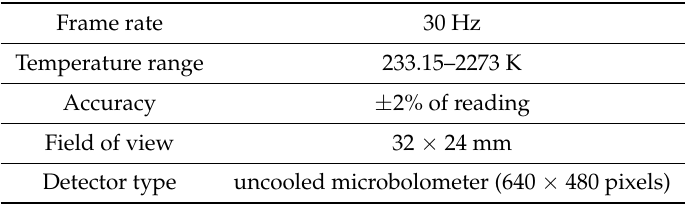
Figure 2. Thermal-electric measurement setup for investigation of inter-laminar short circuit fault. Table 1. FLIR T640 thermal camera